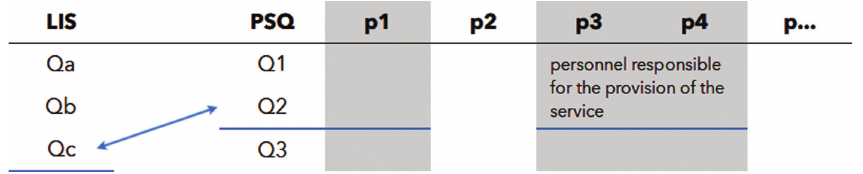
Fig. 2: Example of Mappings. Legend: Q = question, p =